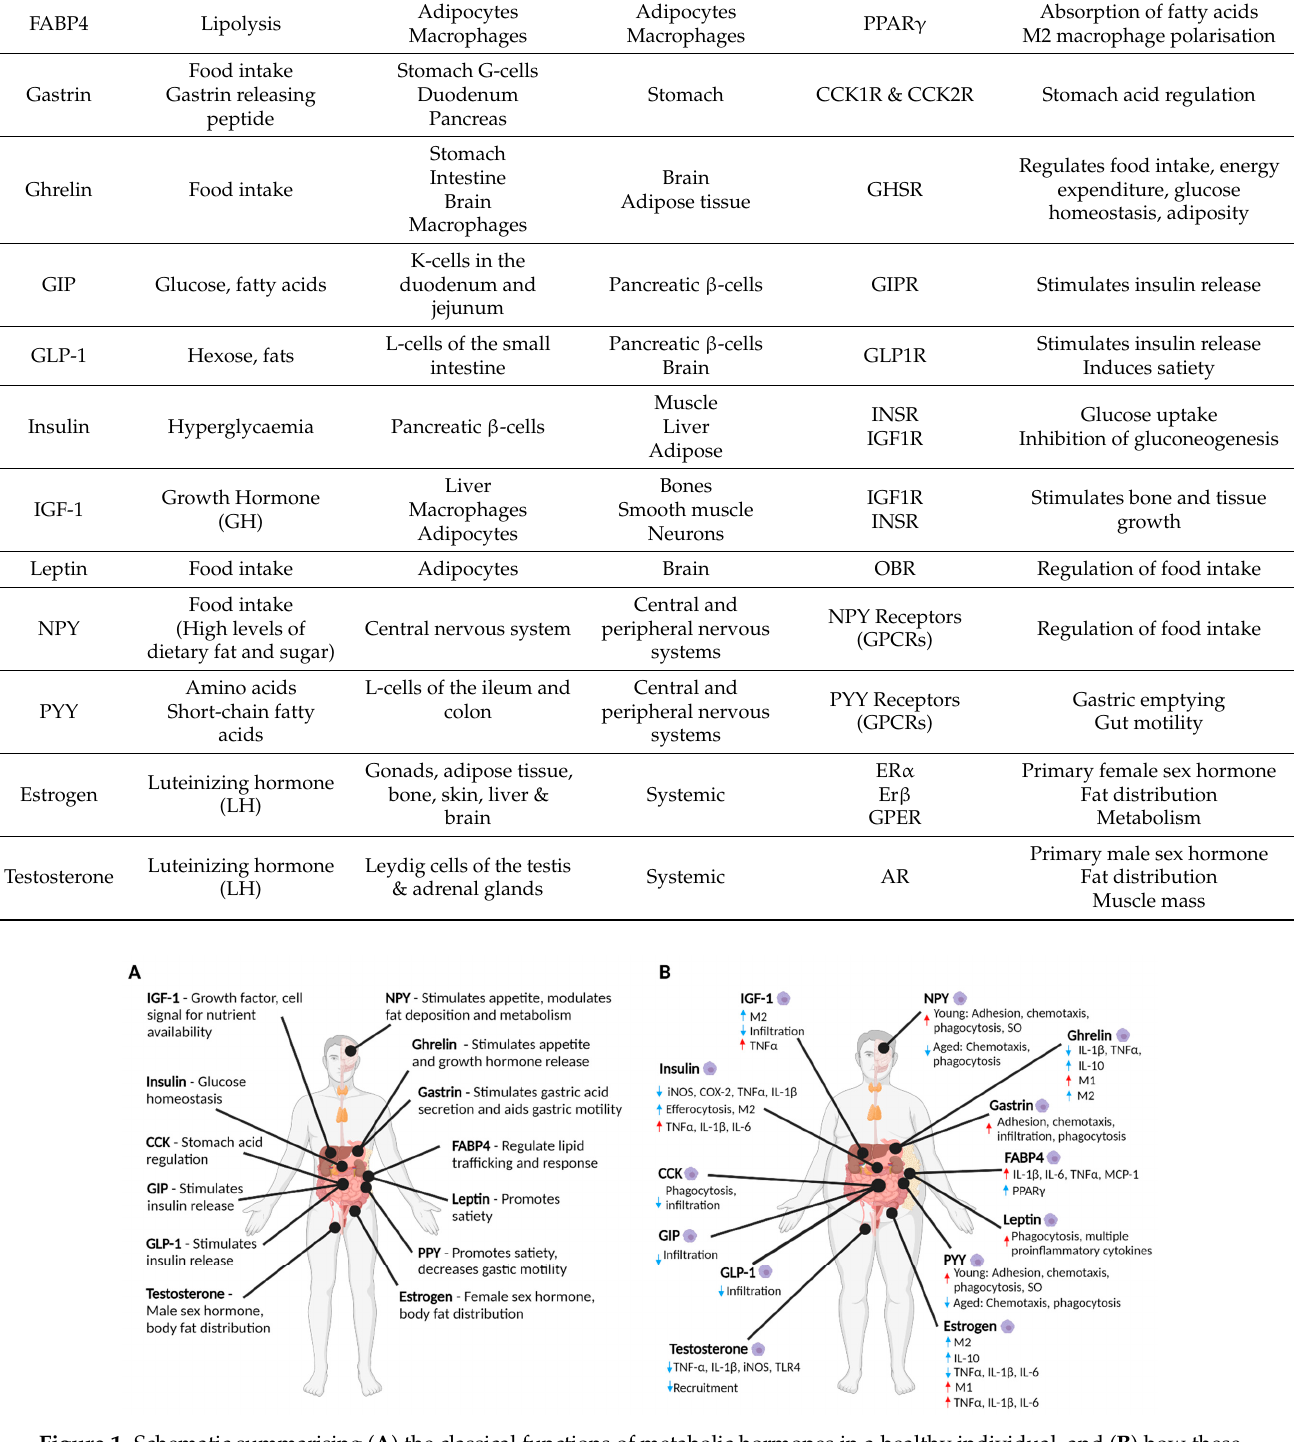
Figure 1. Schematic summarising ( A ) the classical functions of metabolic hormones in a healthy individual, and ( B ) how these hormones can modulate macrophage inflammatory responses when potentially dysregulated in an obese state. Red arrows indicate proinflammatory actions, blue arrows indicate anti-inflammatory actions. This figure was created with Biorender.com.